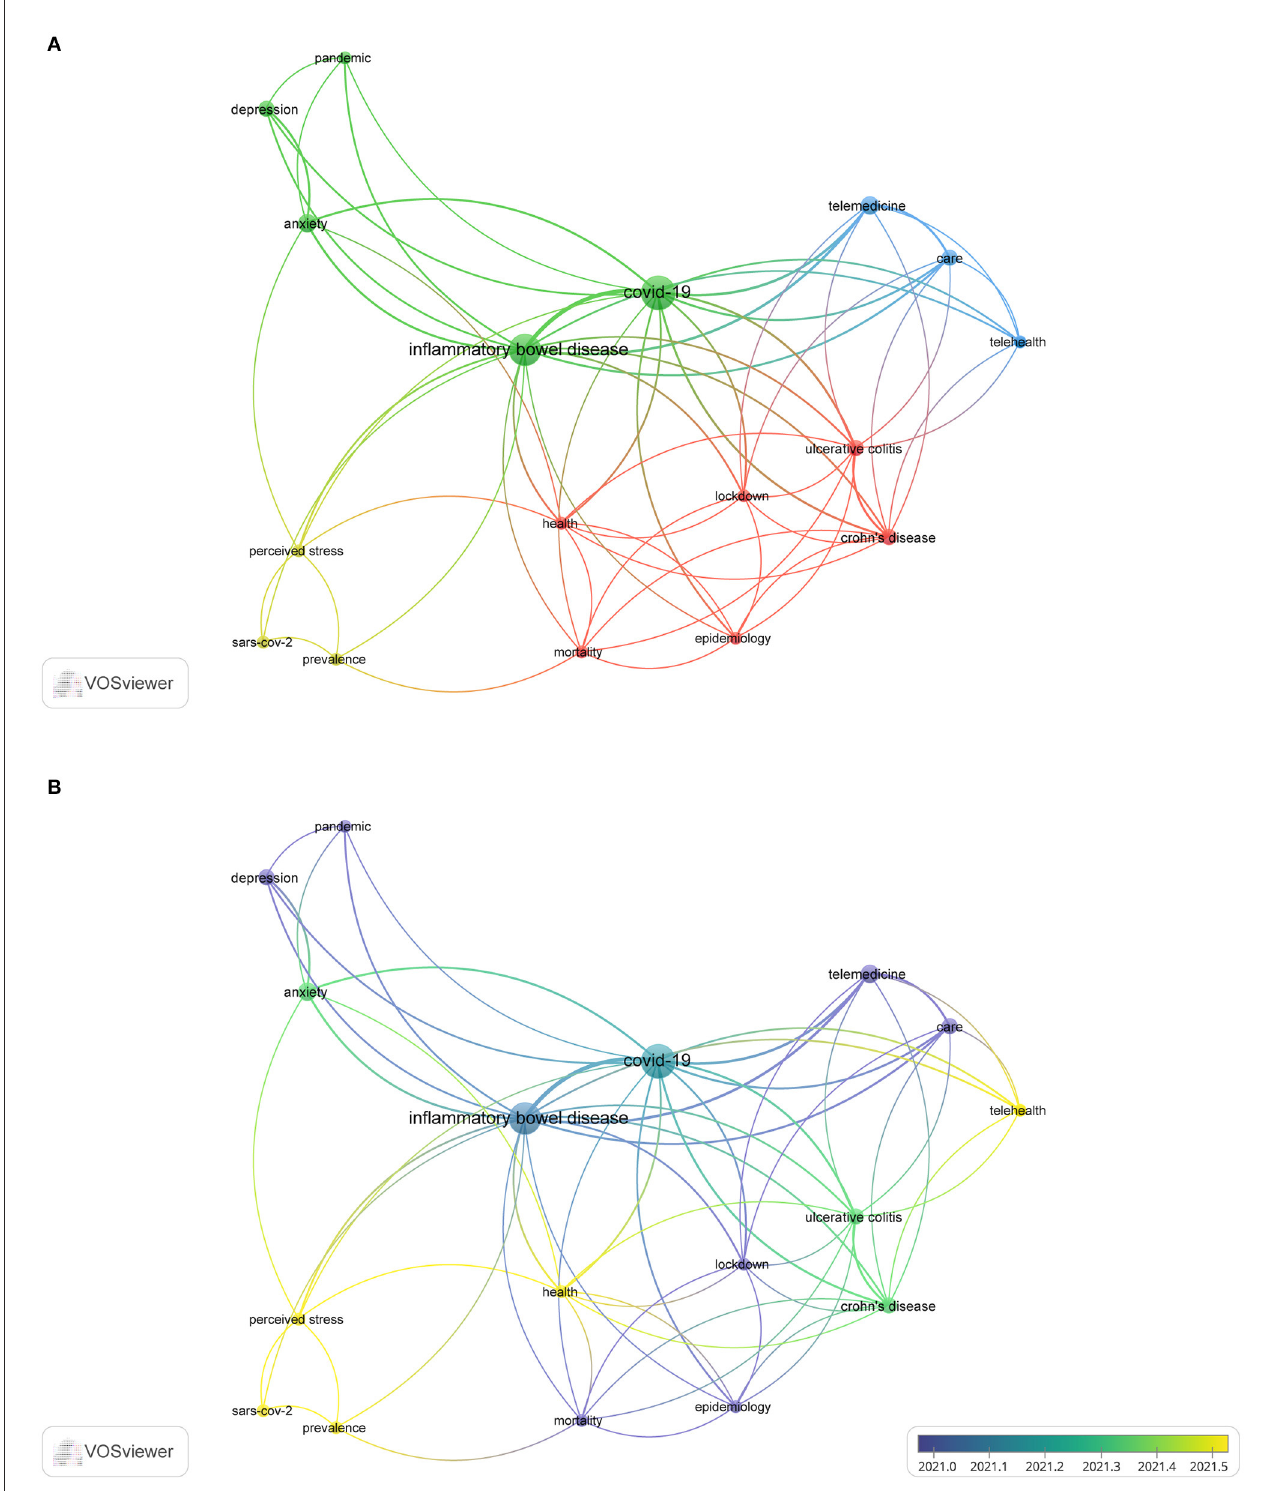
FIGURE8 The co-occurrence of keywords (A) and time sequence chart of keywords (B) of the literature on the impact of COVID-19 on IBD patients.